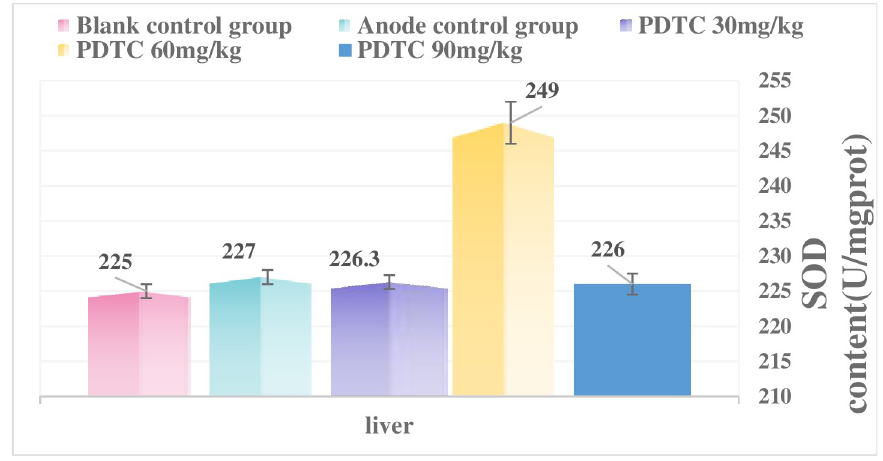
Fig 5. Total liver SOD activity after